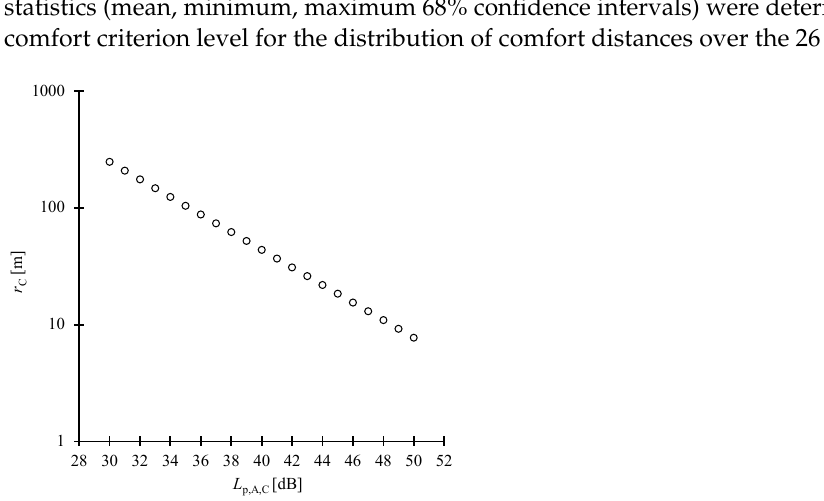
Figure 3. Example of the comfort distances, r C , obtained for office ID 1 for different comfort criterion levels, L p,A,C , from 30 to 50 dB. Table 2. Eight studies I–VIII reporting measurement data according to ISO 3382-3. N is the num- ber of reported paths.